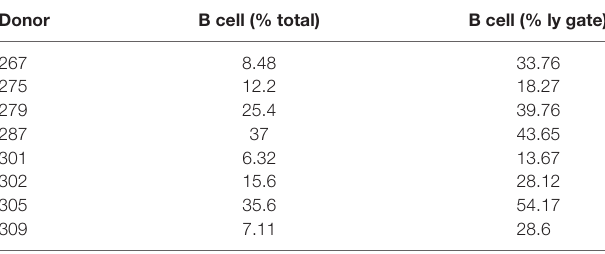
MD, USA; Cat. No. 351-008-491). library Preparation and